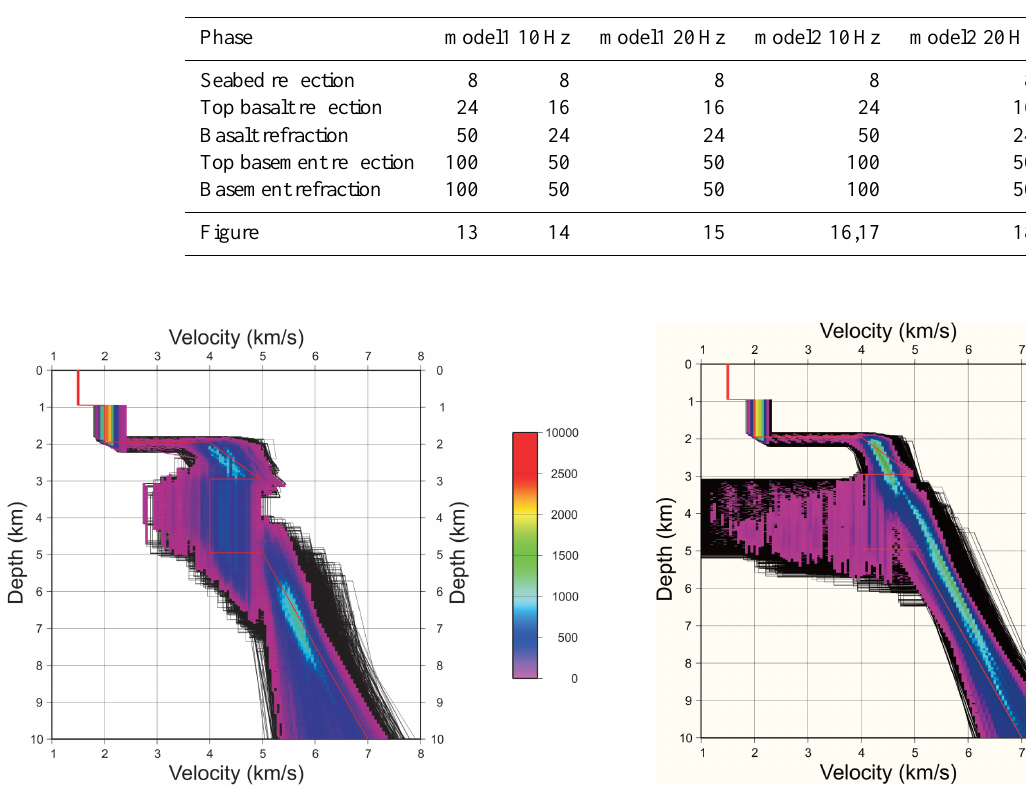
Fig. 13. Results obtained after using the Metropolis algorithm on data from model 1 and 10Hz for 40000 cases. Red line represents the real model and every black line a modified model. The colour scale stands for the number of times that a model (or part of it) is visited. The preferred model (blue colours) overestimates the sub- basalt layer thickness as well as the velocity for this layer.